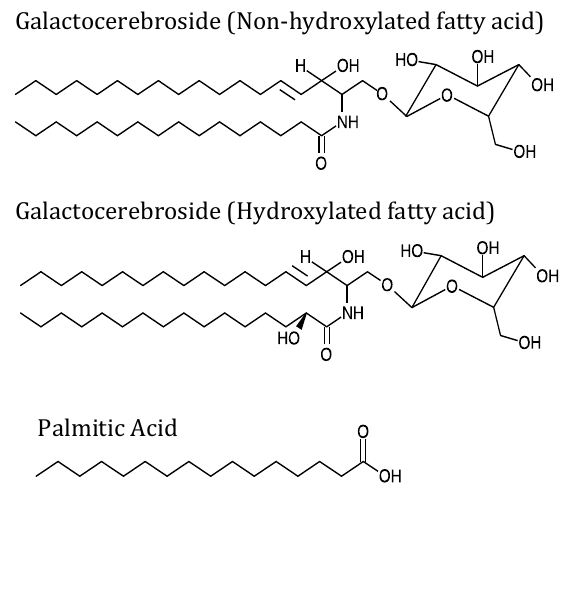
Figure 1. Molecular structures of non-hydroxylated fatty acid (NFA) galactocerebroside, hydroxylated fatty acid (HFA) galactocerebroside, and palmitic